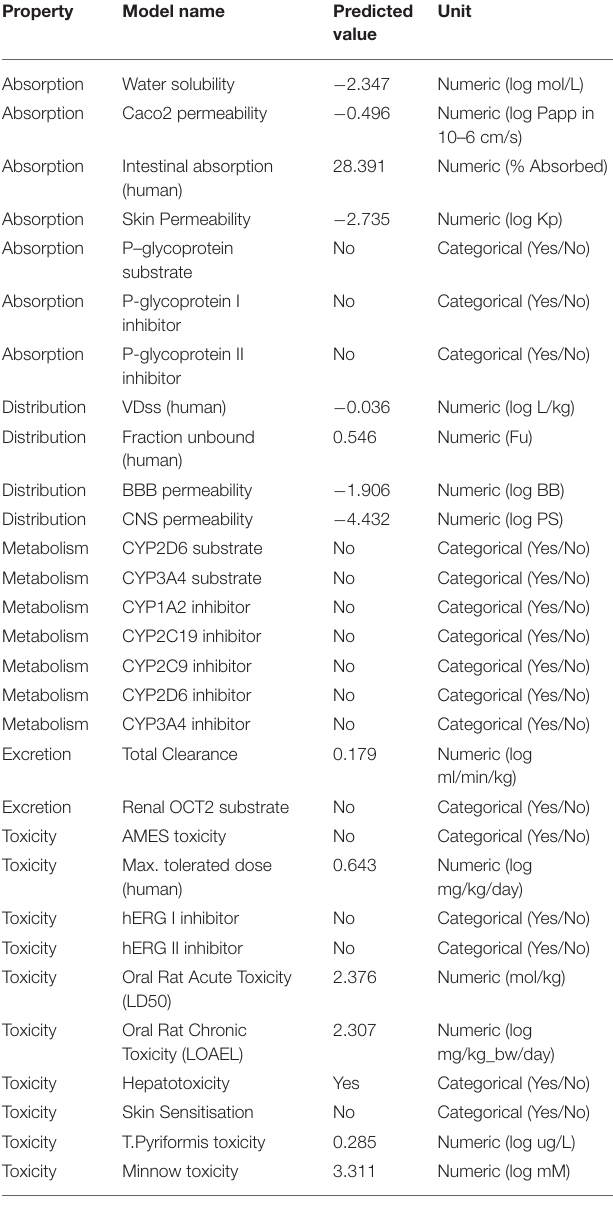
TABLE 4 | ADMET properties of the novel lead compound obtained from the pkCSM server.